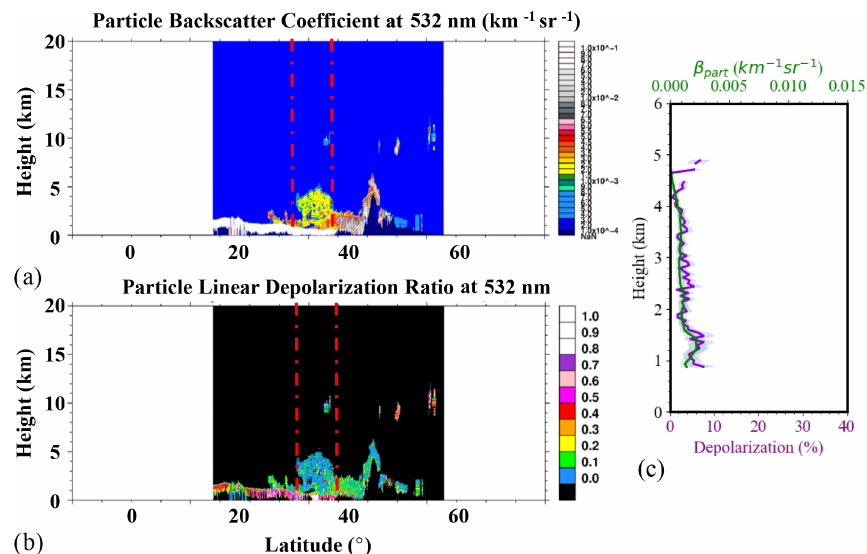
Figure 5. CALIPSO backscatter coefficient (km − 1 sr − 1 ) and PLDR (%) that correspond to the nighttime overpass on 8 August 2017, 10:27– 10:41UTC, shown in Fig. 4a. (a) The smoke plume is located between 39 ◦ and 45 ◦ latitude, below 6km in altitude. Dashed red lines denote the spatial averaging applied for the retrieval of optical properties shown in panel (c) . (b) PLDR values at 532nm do not exceed values of 3%–4% at the height of the